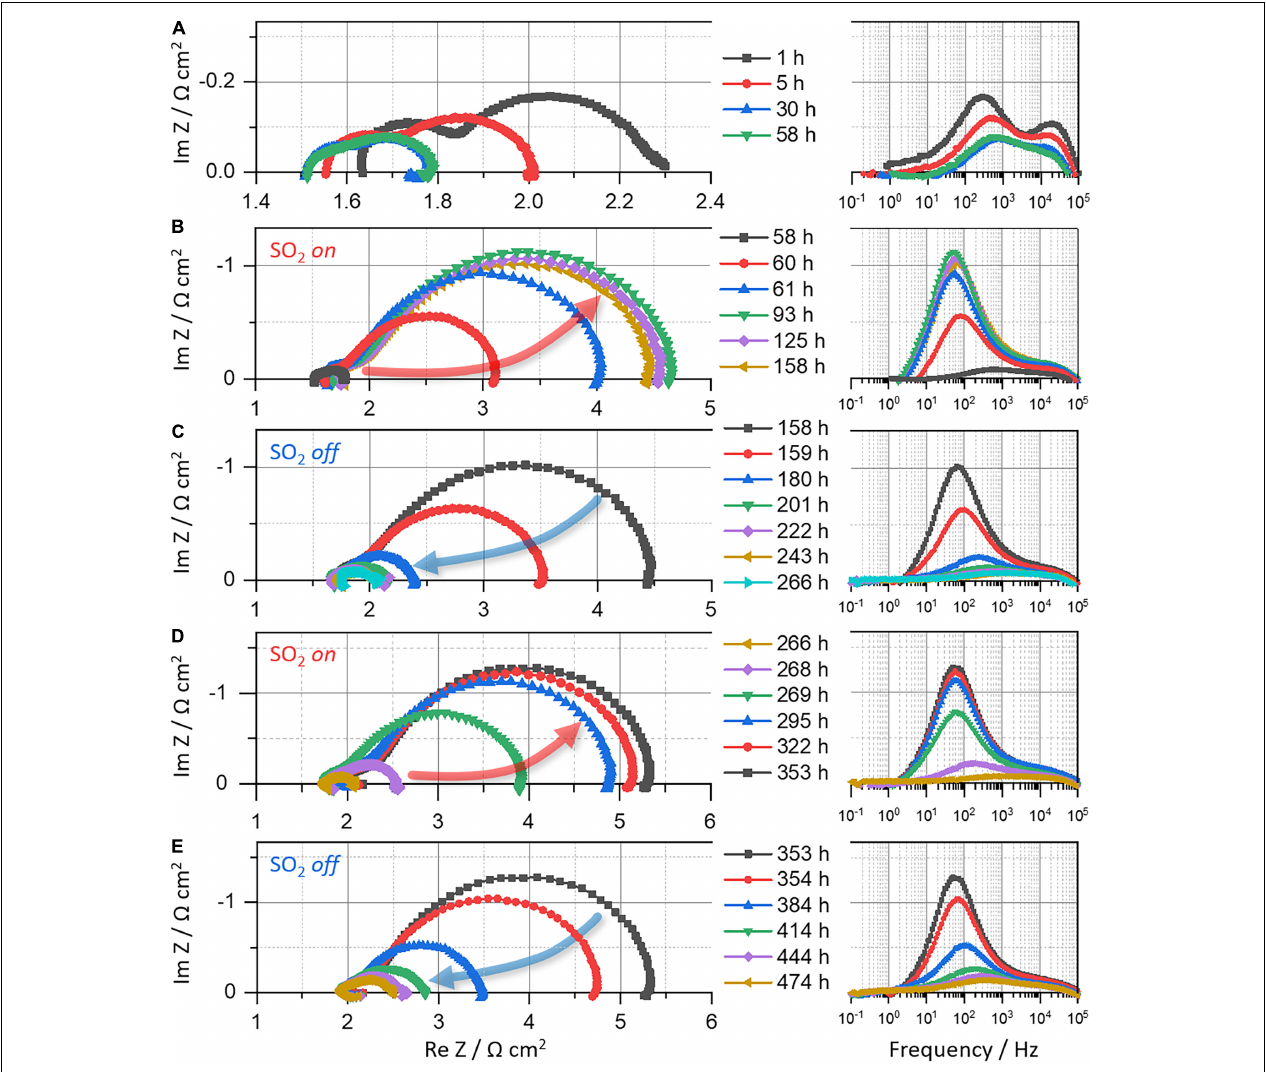
FIGURE 3 | Nyquist and bode plots of LSM|YSZ|Pt cell measured for ∼ 530 h at 700 ◦ C in alternating atmospheres of air (1–58, 158–266, and 353–474 h) and 4 ppm SO 2 ( g ) (58–158 and 266–353 h): (A) 1–58 h, (B) 58–158 h, (C) 158–266 h, (D) 266–353 h, and (E) 353–474